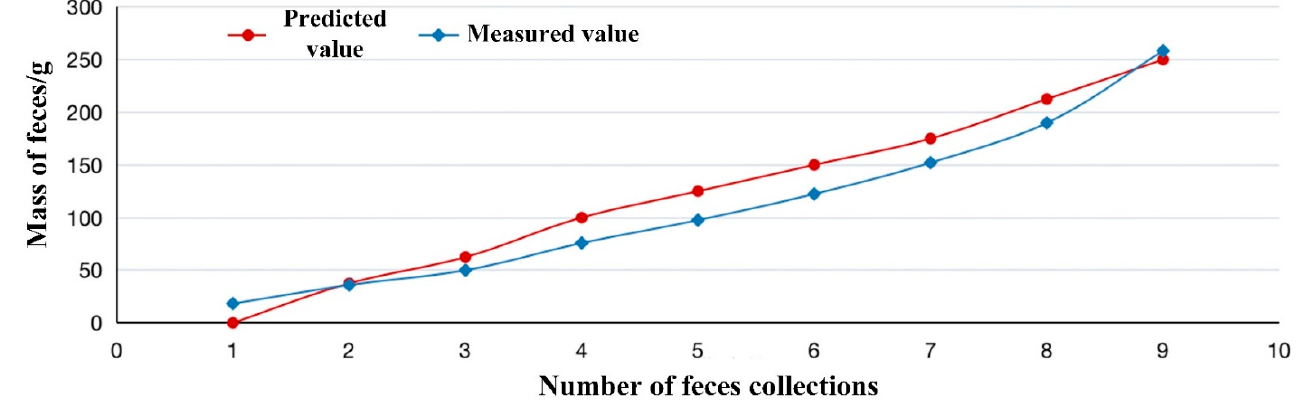
Figure 9. Defecation prediction in vivo experiment based on proposed LSTM model.